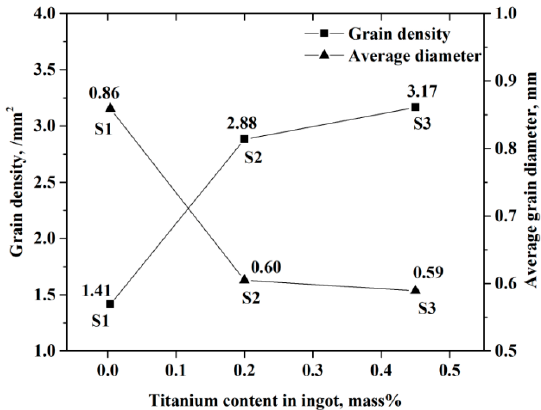
Figure 5. Grain quantity of each sample.